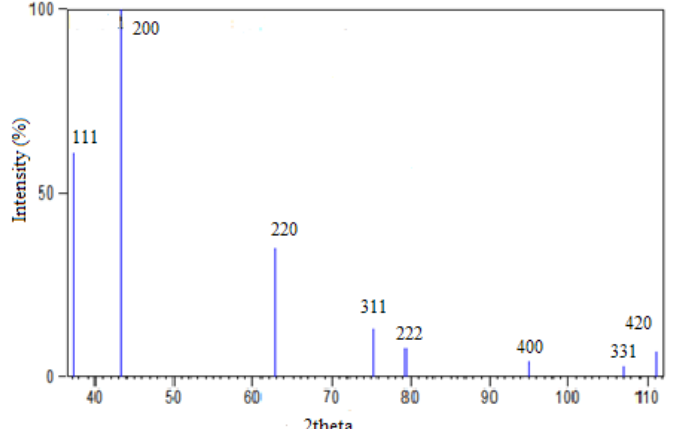
Fig. 9 XRD pattern of CuO nanoparticles prepared by calcinations of nano-powder of compound 1